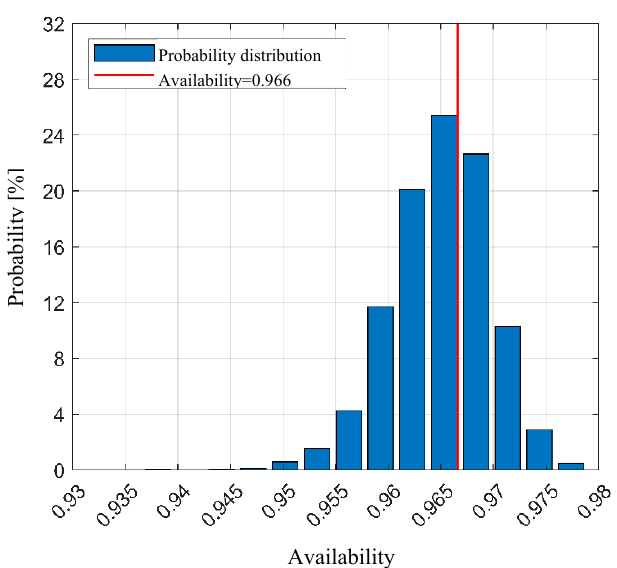
Figure 4. Typical output of the Monte Carlo approach: the probability distribution of the availability of a given system.